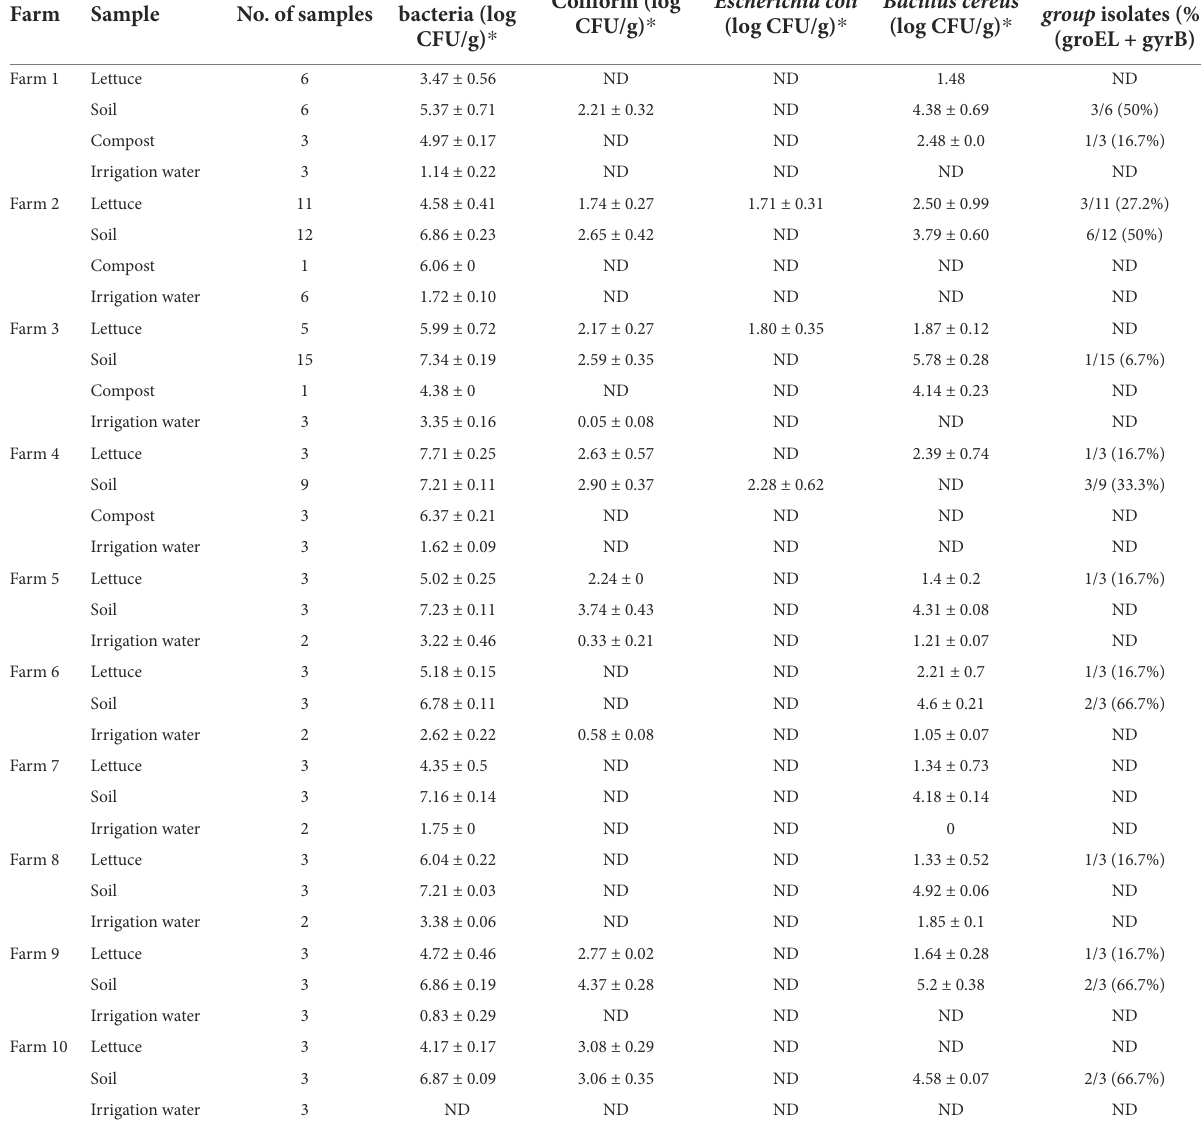
TABLE 3 Population density of indicator bacteria and Bacillus cereus in lettuce and its production